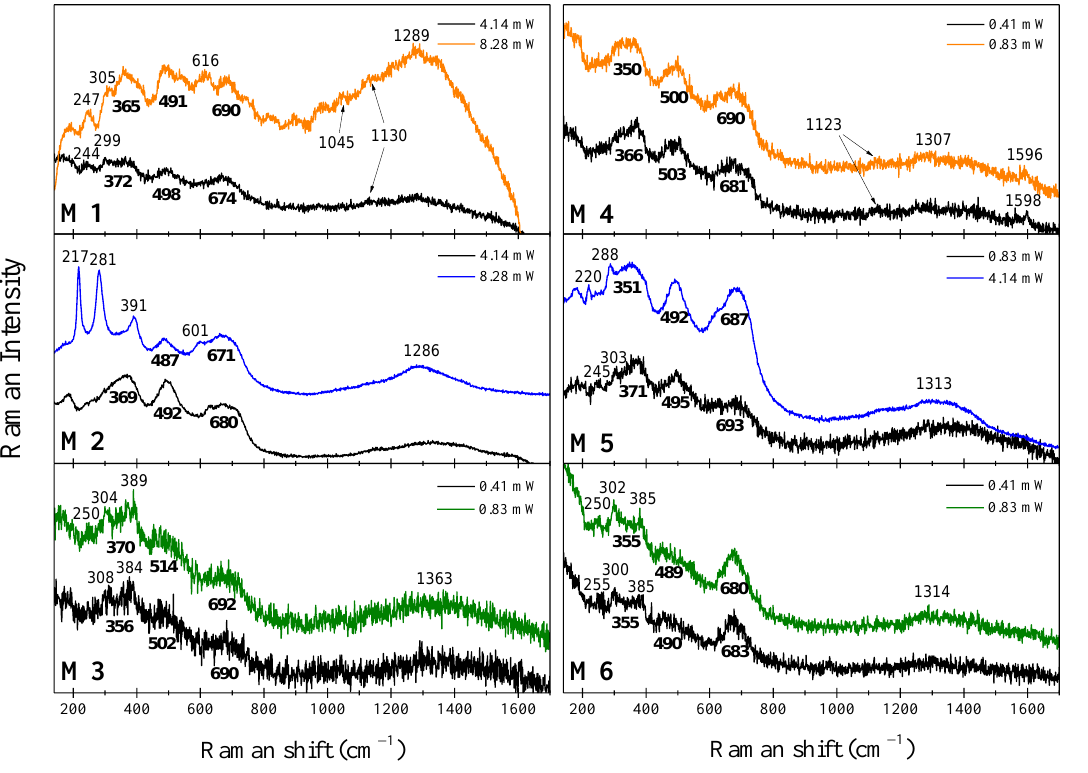
Figure 2. Raman spectra of the samples M1-M6 at different laser power values. The Raman shift of each mode is indicated in cm −1 and the γ -Fe 2 O 3 broad modes are bolded and put below the corresponding peaks. The equal colors of spectra set (orange, blue, and olive) represent the related functionalizing agents of the samples, i.e., PSS, OA, and CTAB.